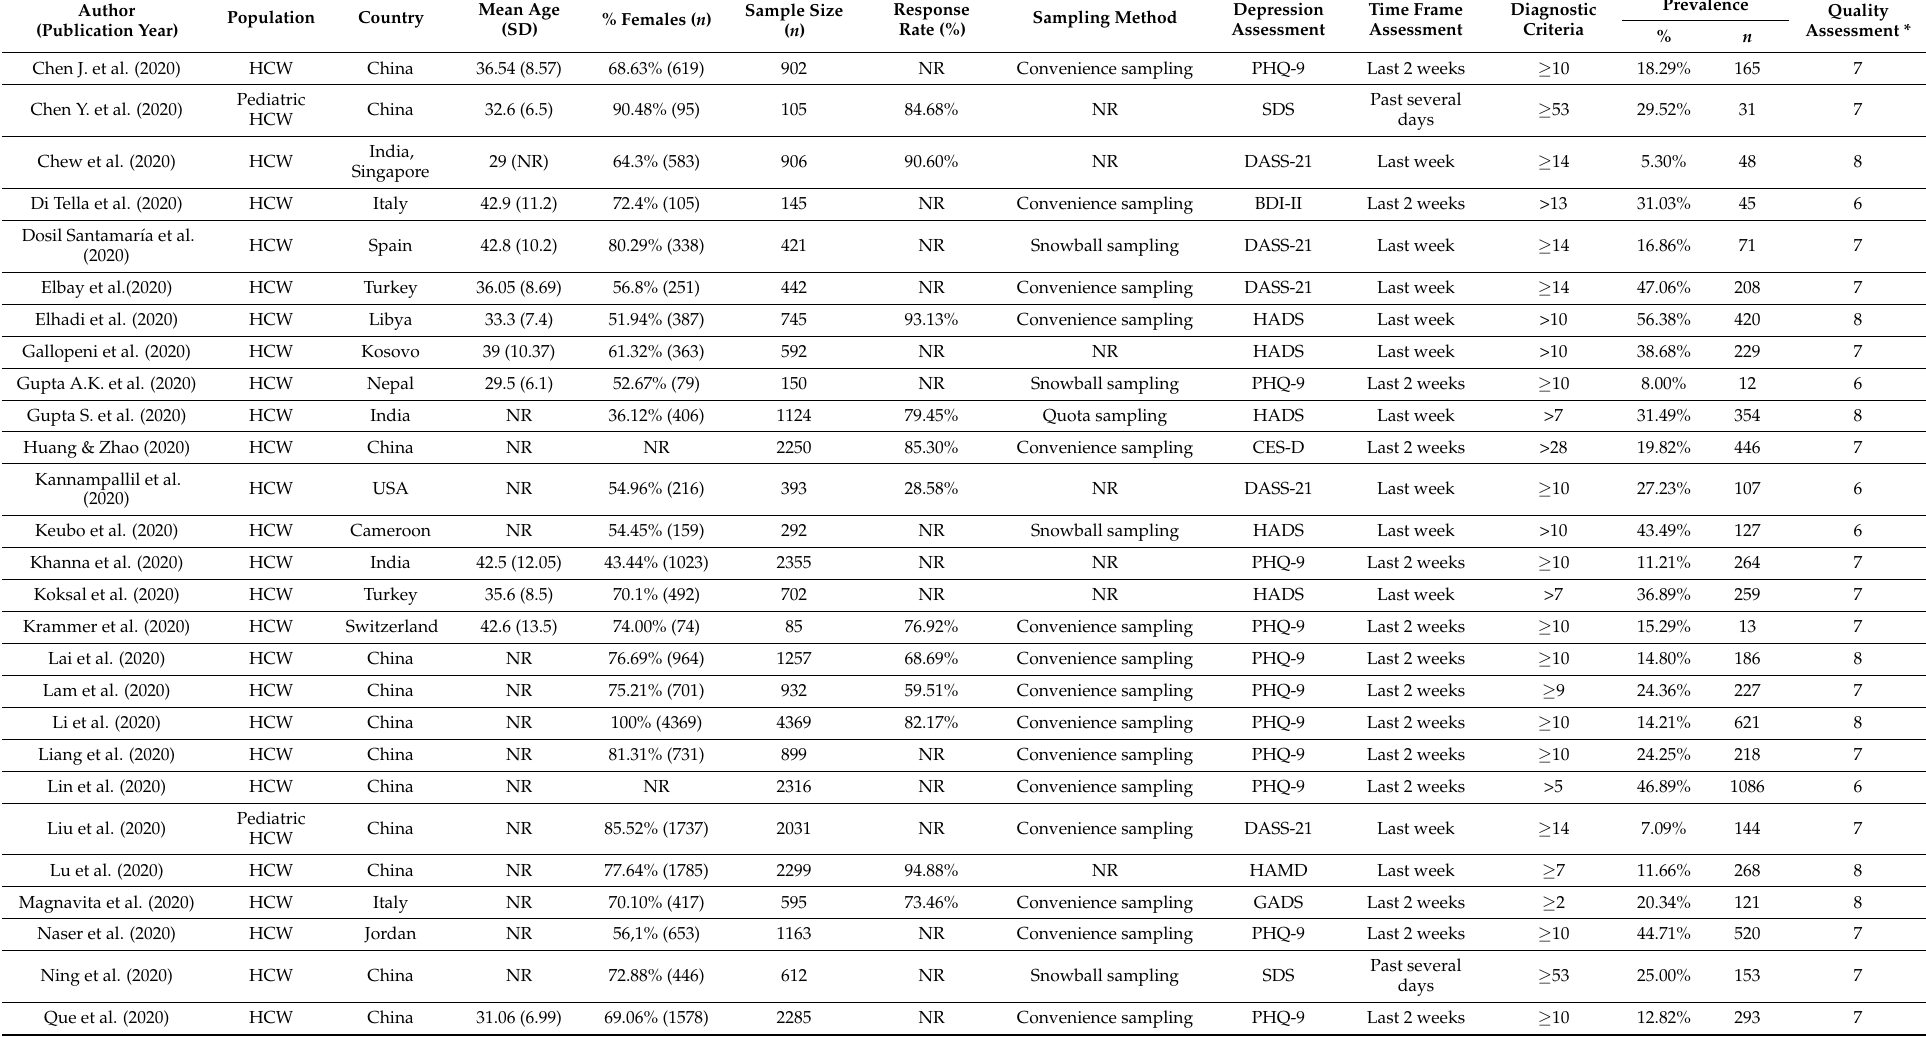
Table 1. Characteristics of the studies included in the meta-analysis based on samples of healthcare